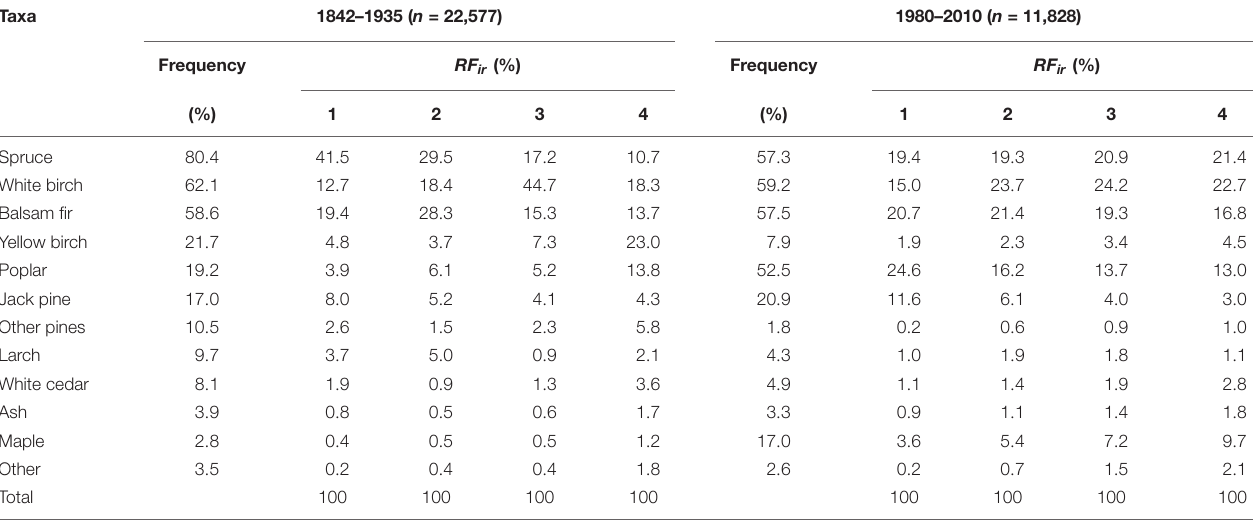
TABLE 1 | Taxa frequencies and ranked frequency index ( RF ir ) for pre-settlement (1842–1935) and modern (1980–2010) periods.